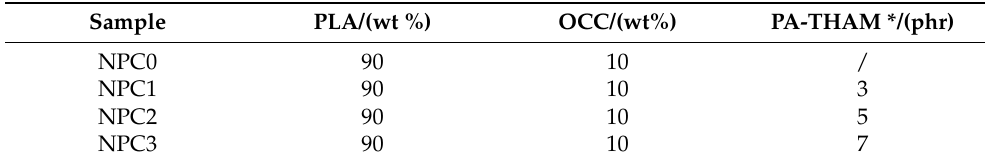
Table 1. Formulations for PLA-based NPCs.